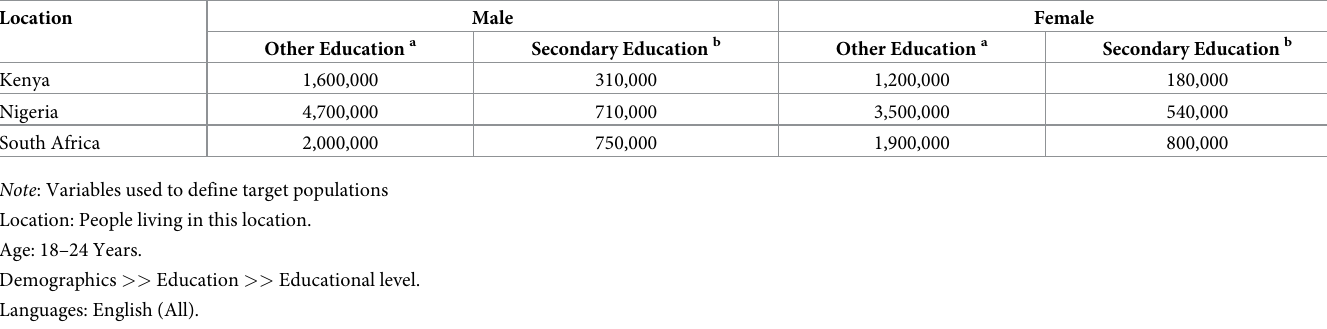
Table 1. Facebook’s assessment of the potential reach of advertisements for young adults in Kenya, Nigeria, South